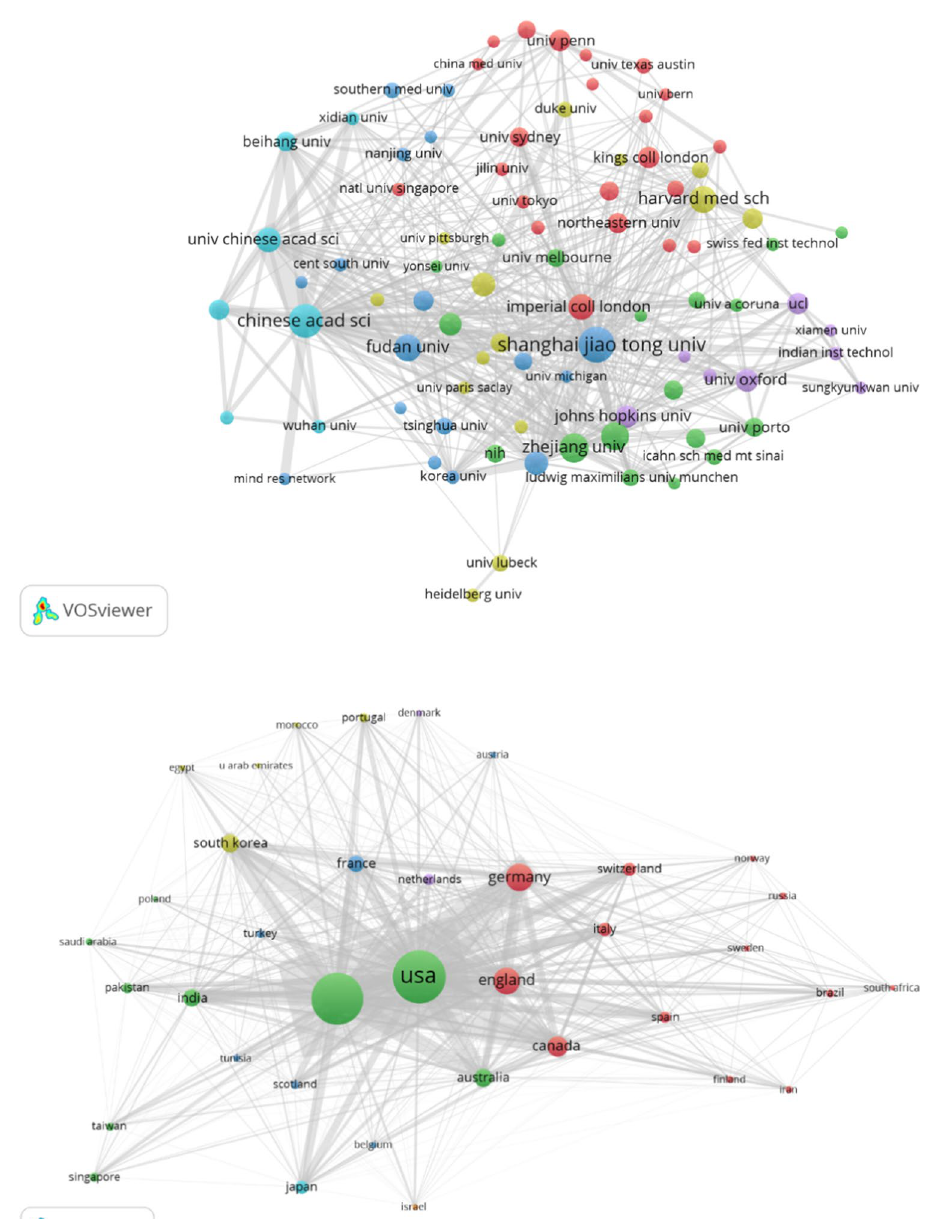
Fig. 12 Institute bibliographic coupling network of MMDLM- related publications